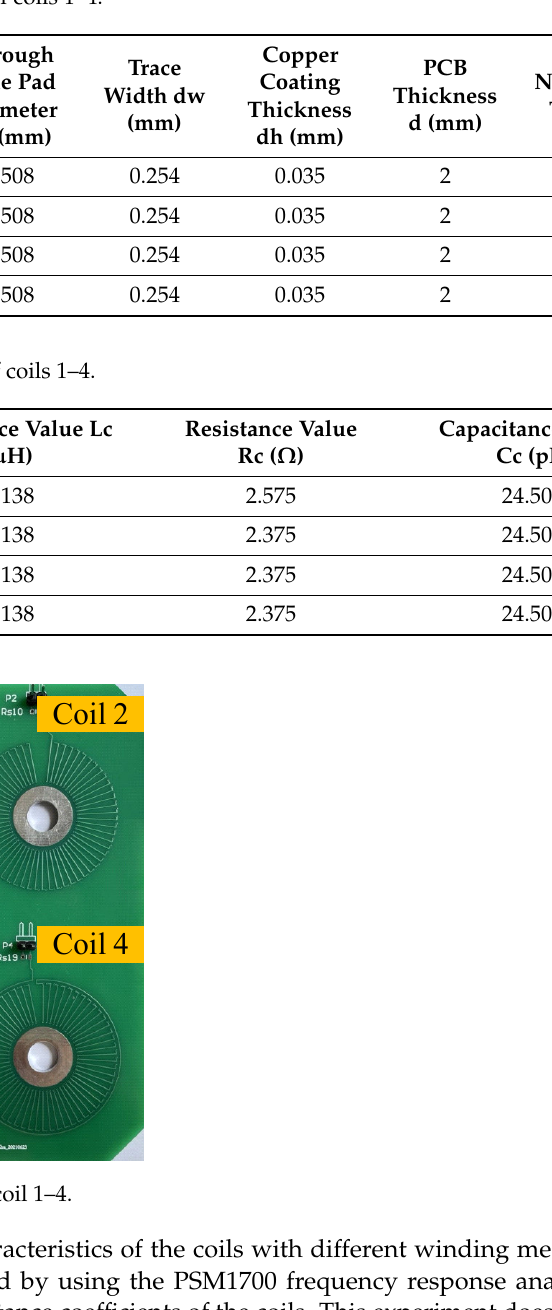
Table 1. Structural parameters of coils 1–4.